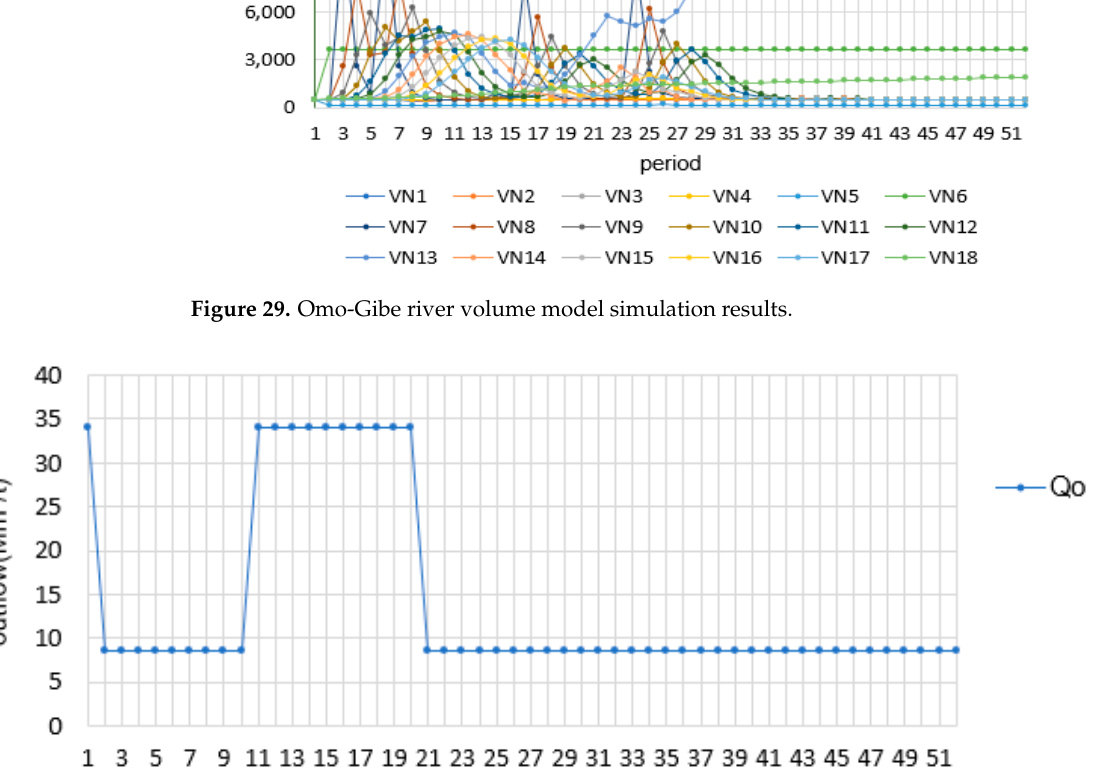
Figure 30. Water allocation for the downstream river flow model simulation (Mm 3 /week).